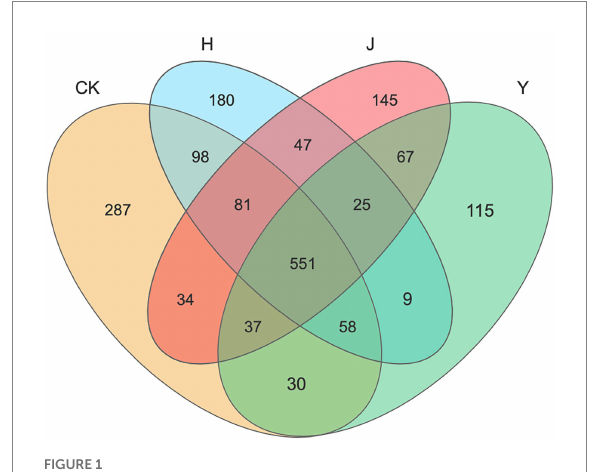
FIGURE 1 Venn diagram of bacteria in the rhizosphere of various treatment groups. Venn diagram demonstrated the numbers of shared and unique observed OTUs at 97% similarity among various treatments. CK represents soybean-potted rhizosphere soil inoculated with 50 mL saline solution. J, Y, and H represent soybean-potted rhizosphere soil inoculated with 50 mL Pseudomonas chlororaphis H1 inoculant, 50 mL Bacillus